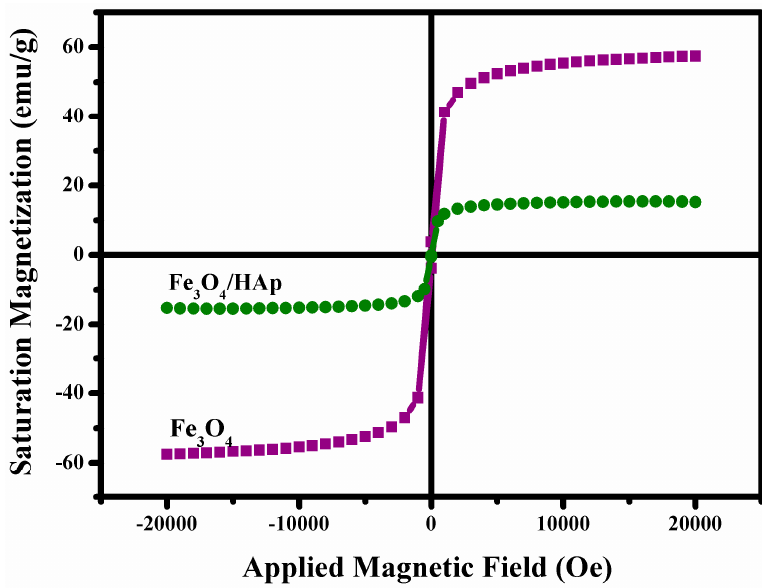
Figure 5. Magnetic (M-H) hysteresis loops of the samples: Fe 3 O 4 nanoparticles and Fe 3 O 4 /HAp nanocomposites measured at room temperature.